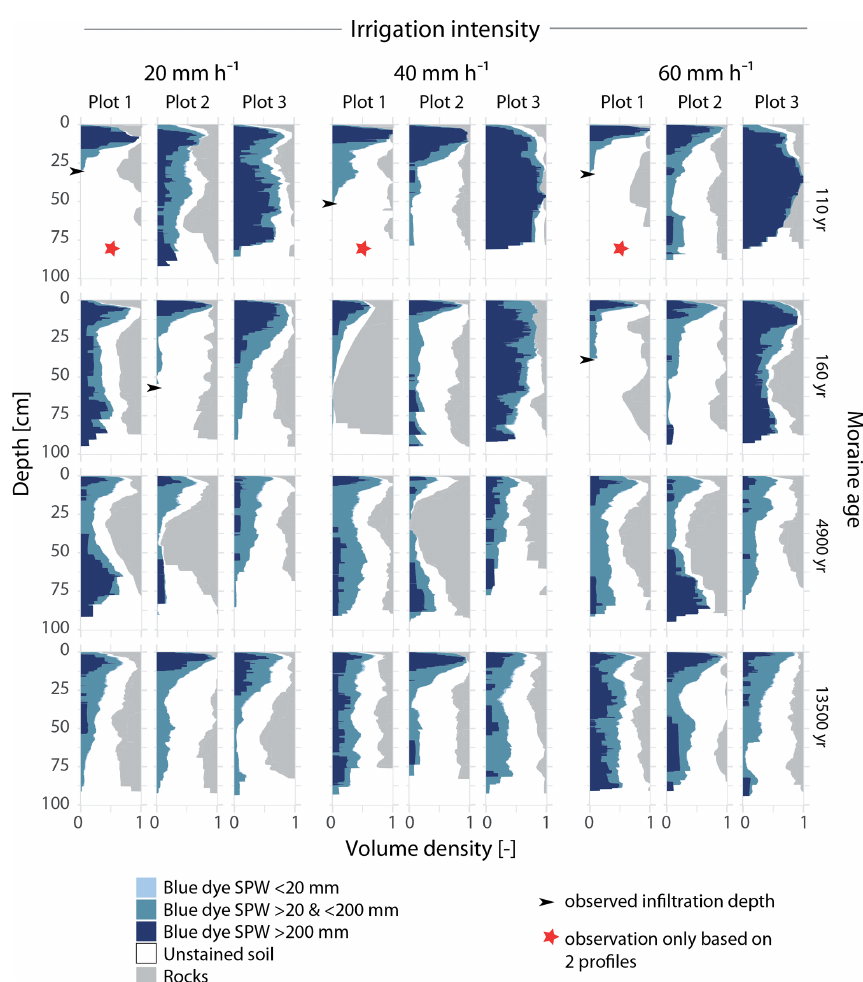
Figure 4. Mean volume density profiles per age class and irrigation intensity. The volume density is the fraction of stained pixels, color coded here by flow path width (stained path width, SPW) and rocks. Maximum infiltration depth was > 1m in 31 of the 36 experiments. Arrows indicate the maximum infiltration depth < 1m at the remaining 5